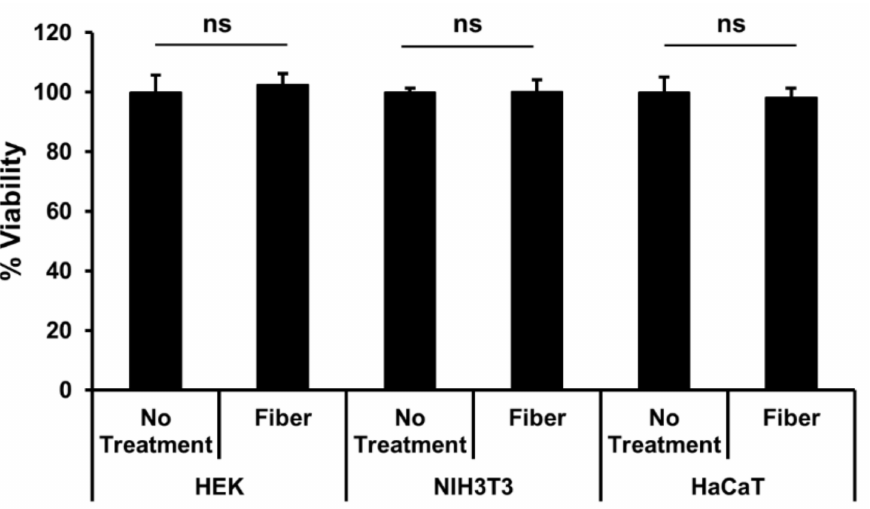
Figure 5. Effect of ECF fibers on the viability of HEK293, NIH3T3, and HaCaT cells. Cells were incubated in the presence of 2 mm length ECF fibers, and the viability was determined by the direct CyQUANT™ assay at 72 h. Cells grown on tissue culture plastic were used as the negative control (no treatment group). Results are expressed as a percentage of negative control and bars indicate mean ± SEM (n = 3 wells for each group), ns = not significantly